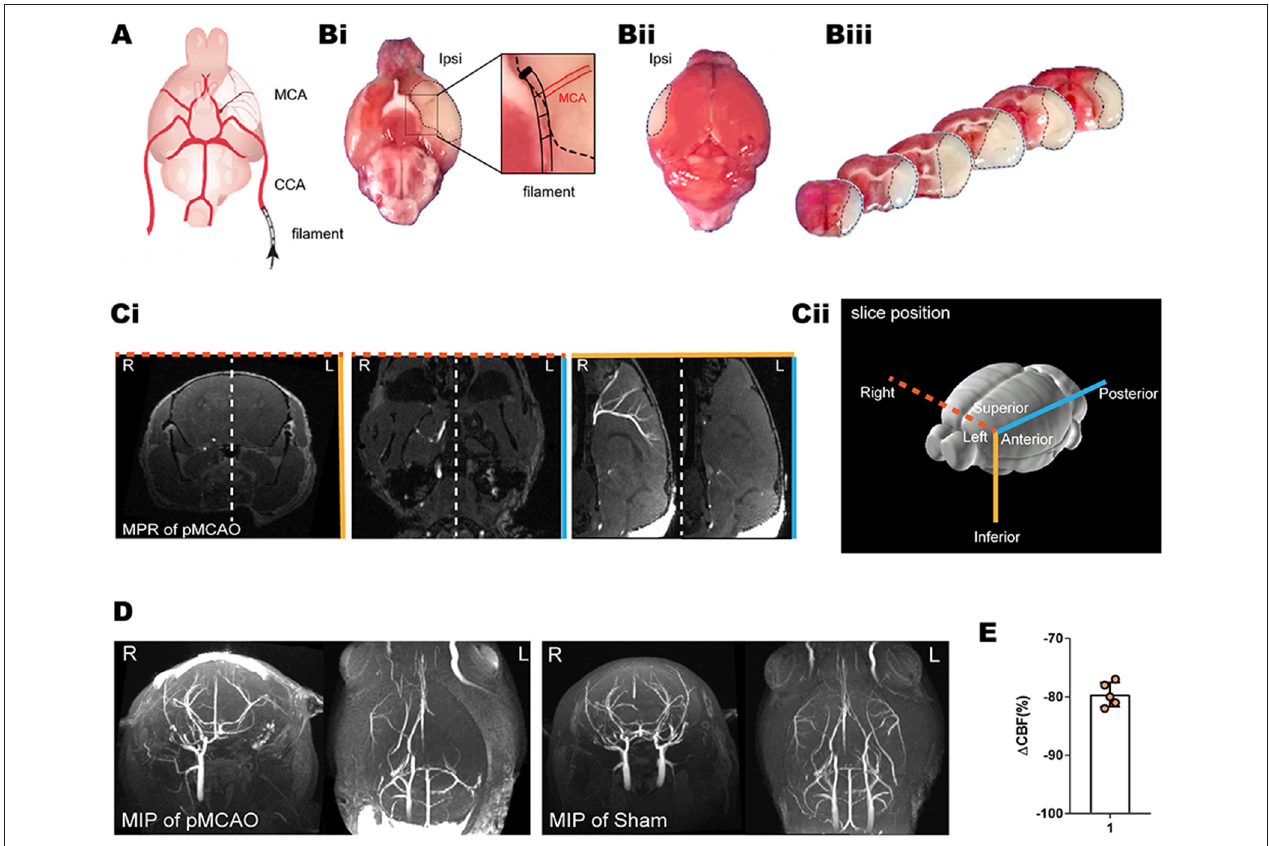
FIGURE 1 | TTC staining, laser Doppler, and MRI of the pMCAO mice model. (A) Schematic diagram of the MCA occlusion. Reproduced with permission (10) (Bi–iii) Representative TTC staining of cerebral ischemia at 24h after pMCAO. A lack of TTC staining was defined as infarction, whereas viable brain tissue was stained red. (Ci,D) The MCA occlusion displayed in coronal, axial, and sagittal planes of MPR and MIP. Bright signals are associated with the vasculature. L indicates the pMCAO side. (Cii) Schematic diagram of the slice positions of the MRI. Color-coded border lines denote the anatomical position of the slice. (E) Ipsilateral relative rCBF after MCAO ensured that the CBF decreased to below 25% of baseline as measured by laser Doppler.